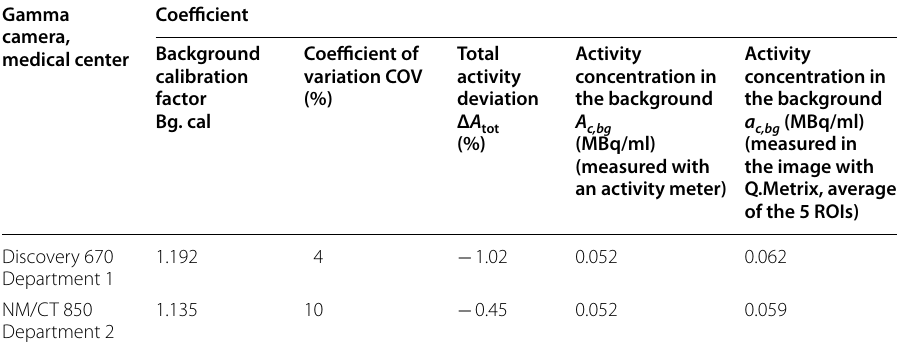
Table 1 Background calibration factor (Bg. cal), coefficient of variation (COV), total activity deviation (Δ A ), background activity concentration ( A ) measured with the activity meter and background tot c,bg activity concentration ( a )—average of the 5 ROIs measured in the image with Q.Metrix, for two c,bg SPECT/CT acquisitions of the cylindrical uniform phantom in two nuclear medicine